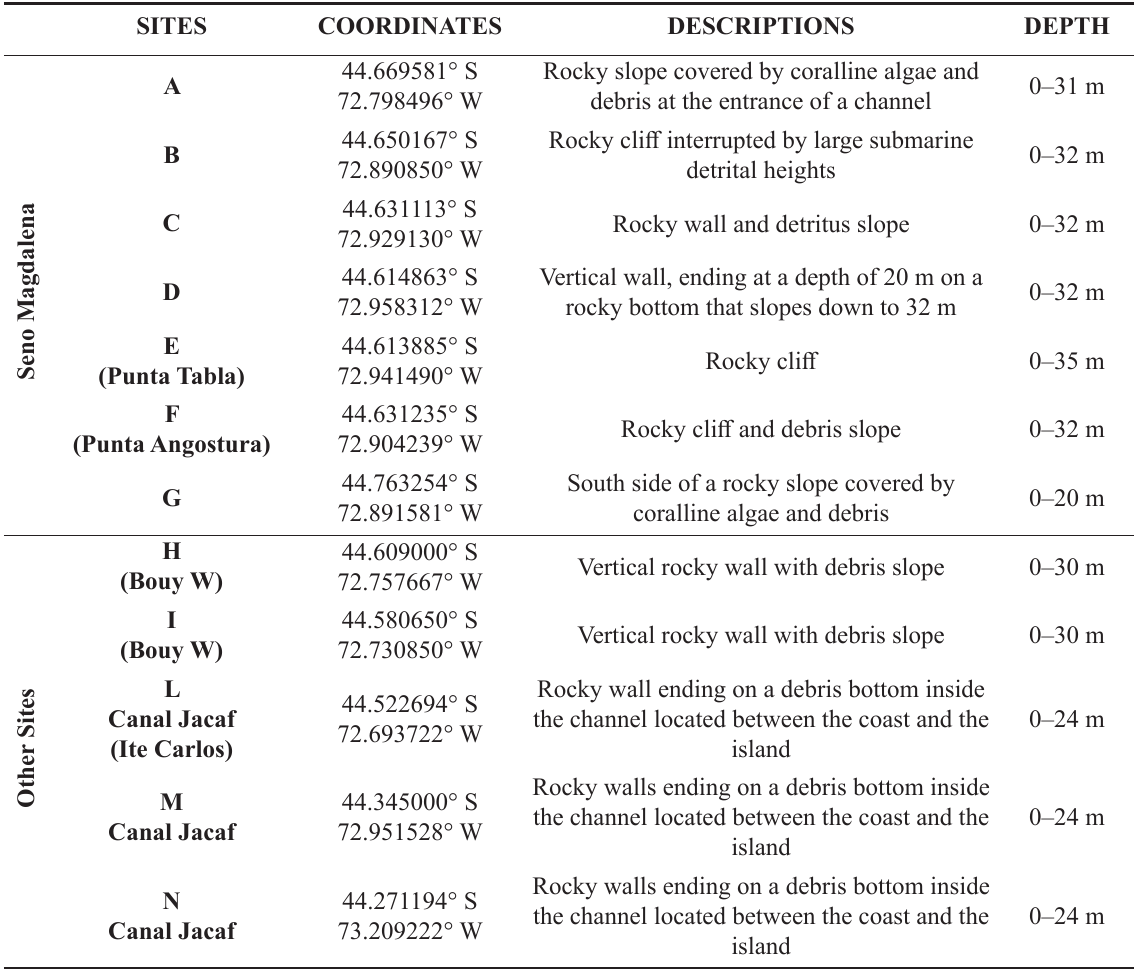
Table 1. Sampling sites with